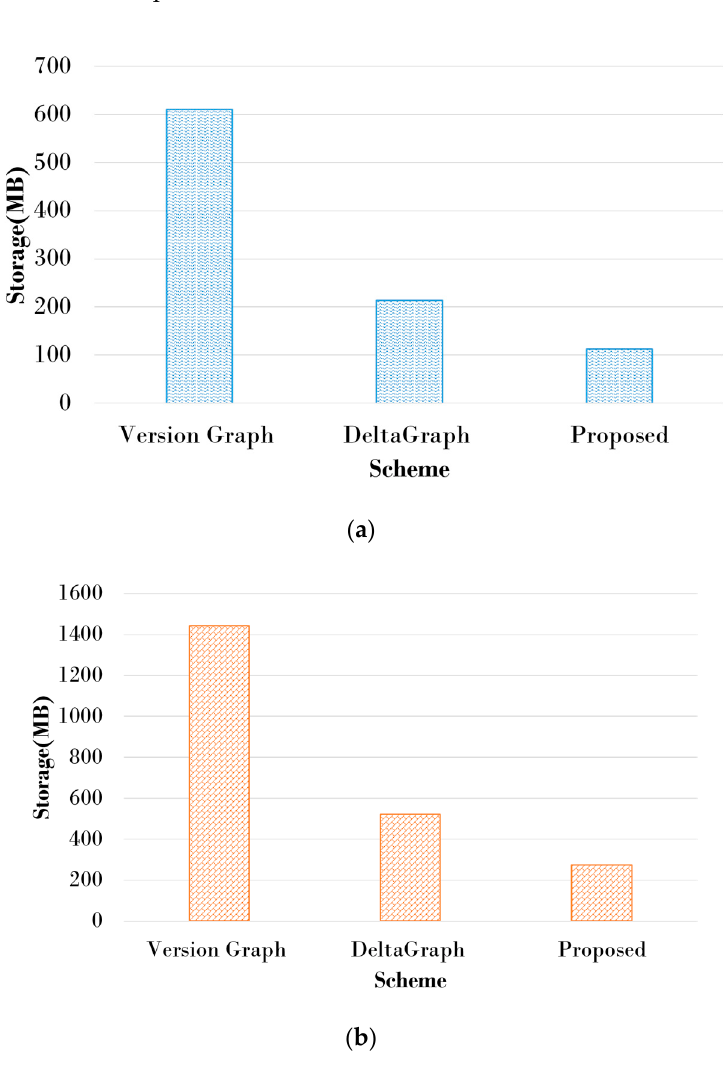
Figure 13. Storage usage comparison: ( a ) Dataset1; ( b ) Dataset2.